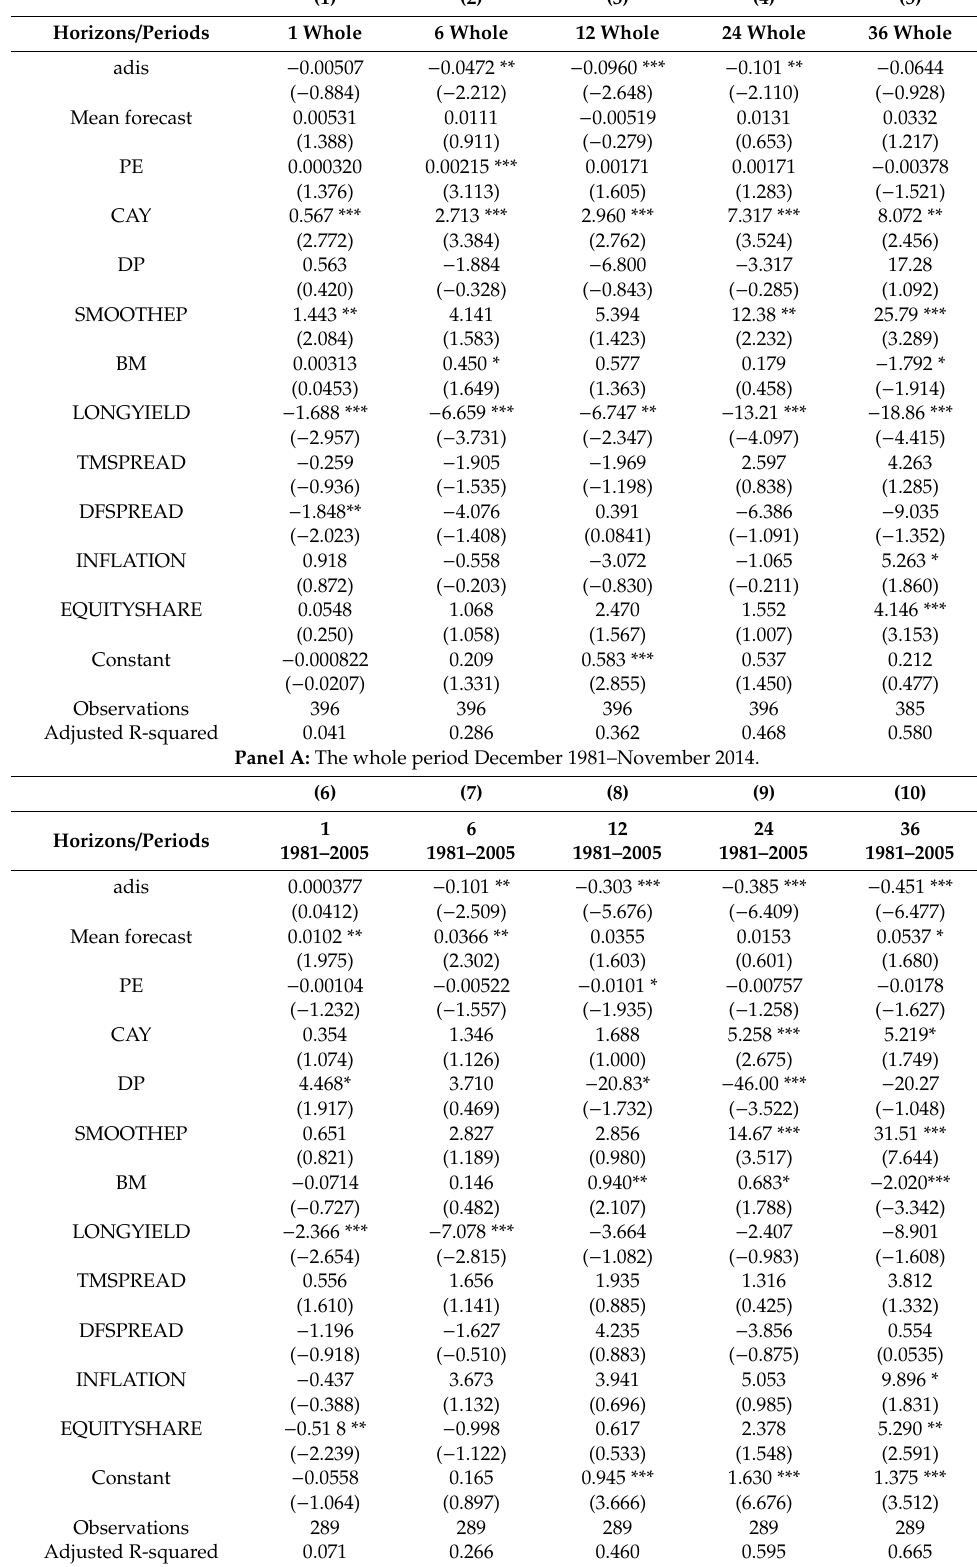
Table 3. Multivariate regressions of future excess market returns on